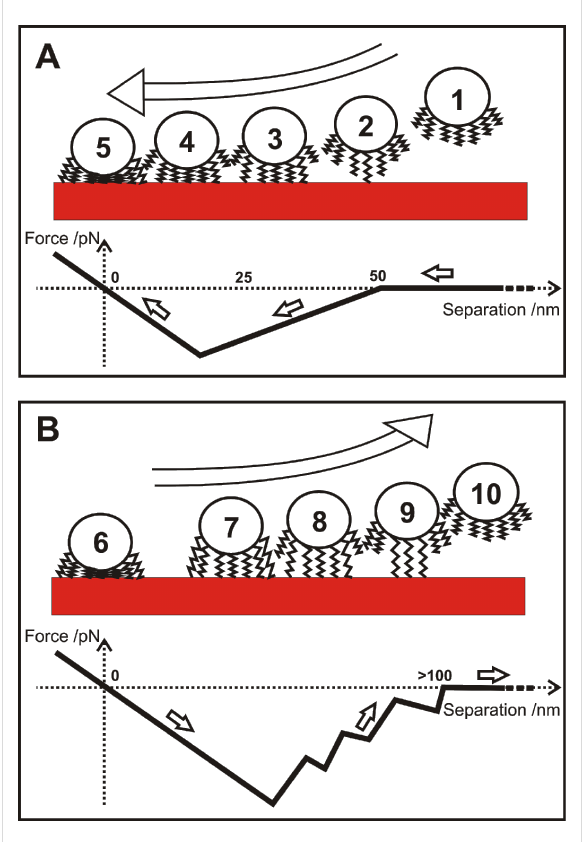
Figure 9: Sketch of approach (A) and retraction (B) of a single bacte- rial probe and respective force/distance curves. For clarity, neither the AFM cantilever nor the macromolecules that are not involved in adhe- sion are drawn.